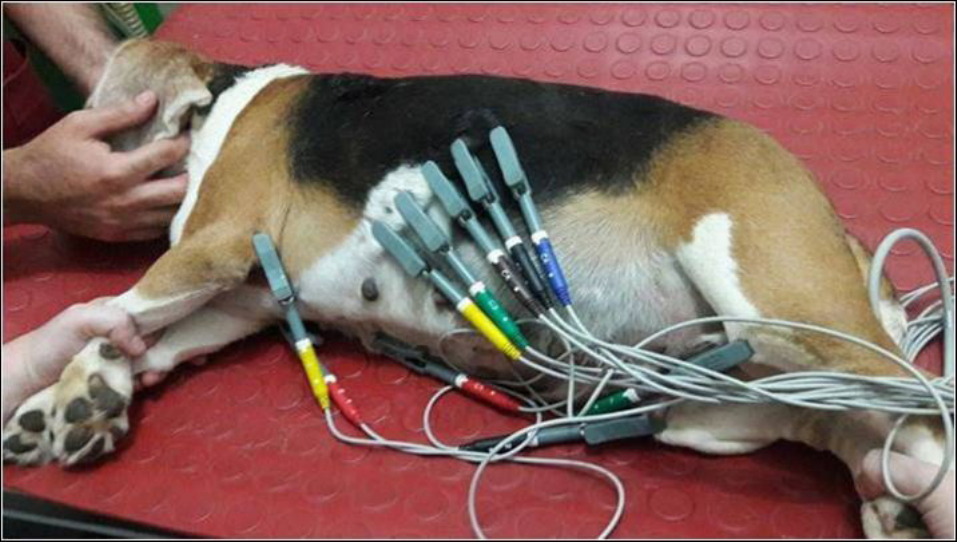
Figure 1. Animal in right lateral decubitus during continuous electrocardiography to record HRV. Source: Service of Cardiology and Respiratory Diseases –